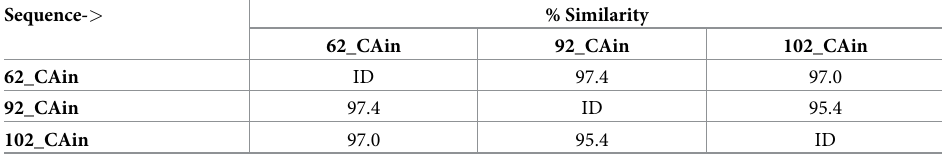
Table 2. Overall similarities between the Cryptosporidium DNA